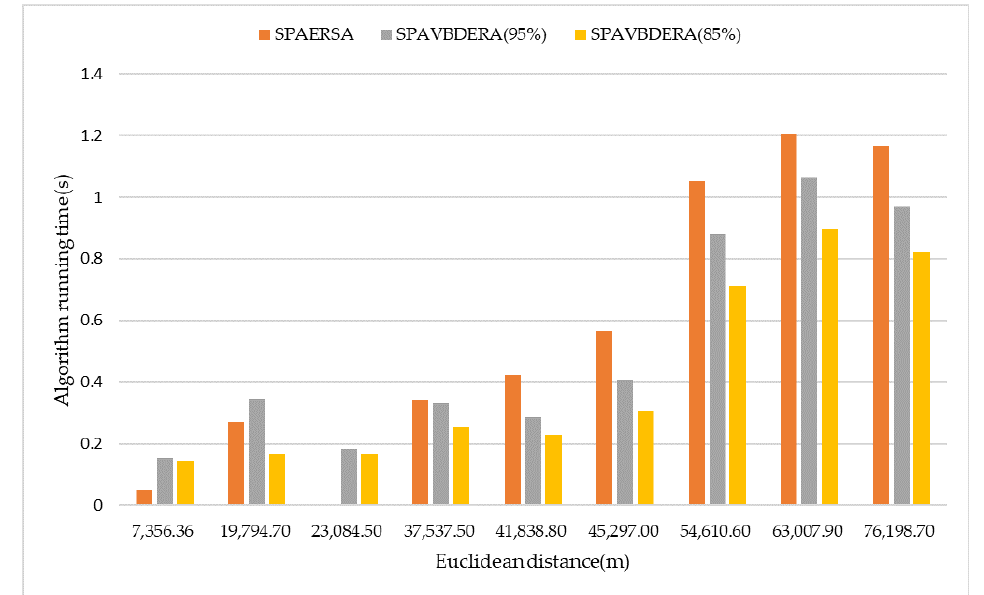
Figure 9. The number of nodes traversed by the three algorithms under different Euclidean distances.